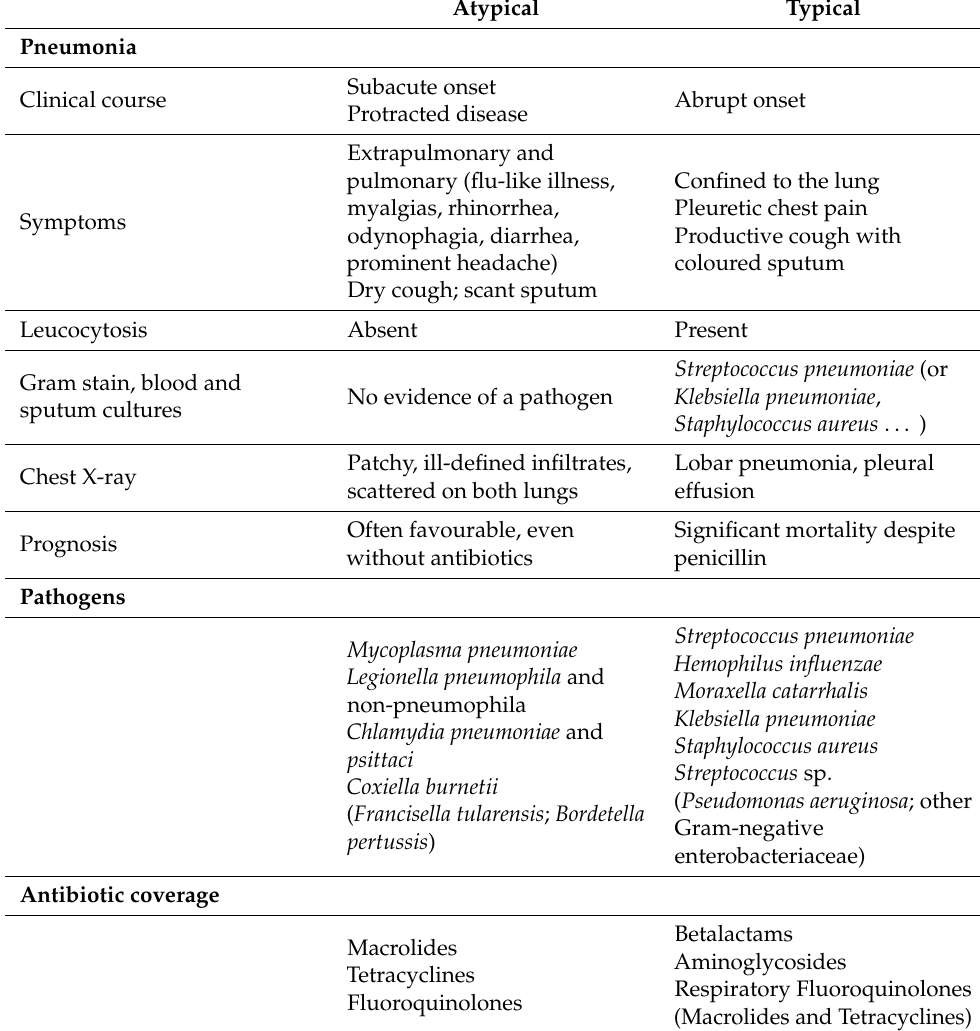
Table 1. Atypical pneumonia, atypical pathogens, atypical coverage [18–20,27]. Atypical